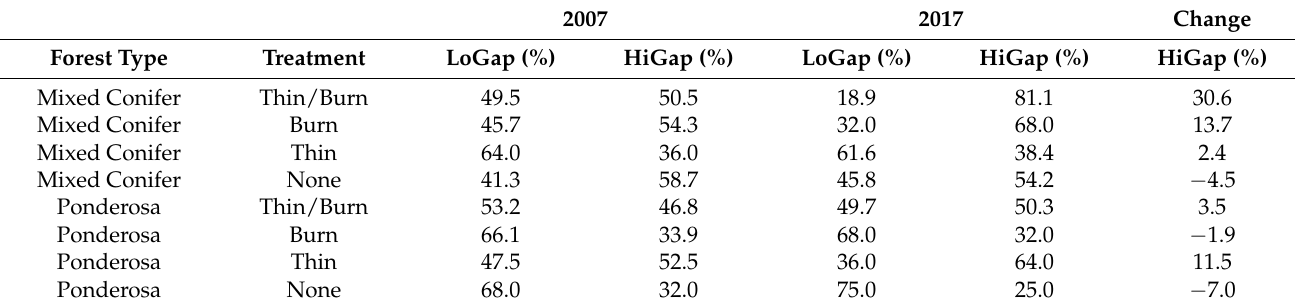
Table 5. LFHAC percentages before and after treatment in each class, and percentage change before and after treatment; ponderosa pine and dry mixed-conifer forest types on the Malheur National Forest near John Day, OR,